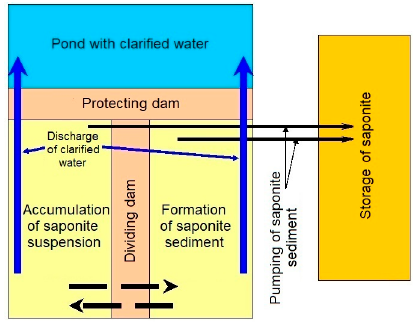
Figure 3. Layout of a tailing pond with cryogenic treatment. Reproduced with permission from F.S. Karpenko [1].